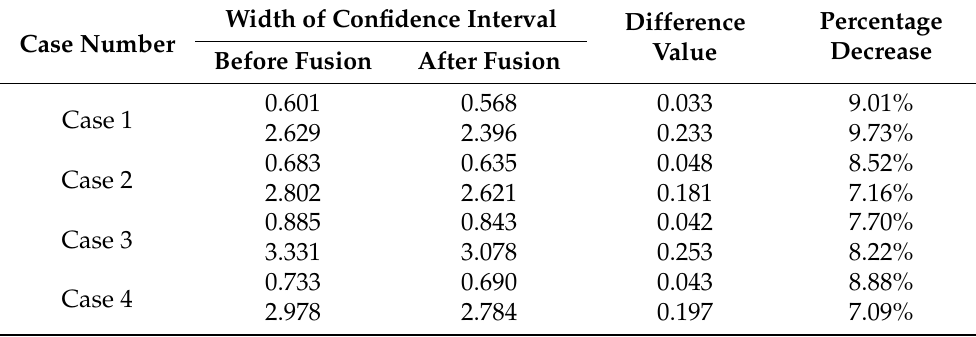
Table 6. Confidence interval width of the fitting equation of lateral displacement and wind speed in the mid-span of the bridge before and after the fusion.